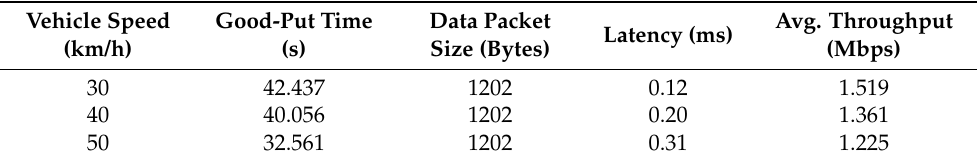
Table 3. Test measurement results for Vehicle-to-Vehicle communication